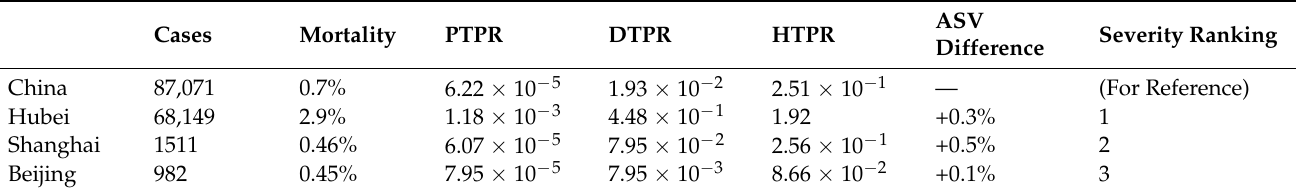
Table 4. The Ratios of Four Measures of Pandemic